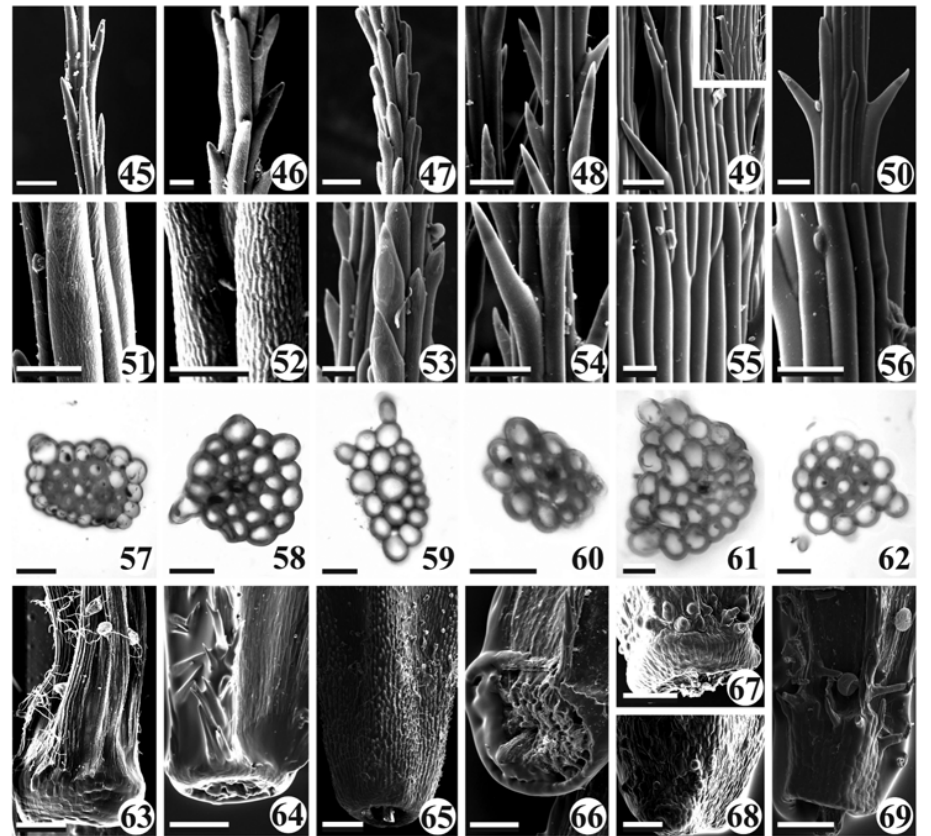
Fig. 4 – Micromorphology (first and second rows) and transversal sections of the pappus (third row), and micromorphology of the carpopodium (fourth row). Figs. 45, 51, 57, 63 – Campuloclinium macrocephalum . Figs. 46, 52, 58, 64 – Chromolaena stachyophylla . Figs. 47, 53, 59, 65 – Mikania micrantha . Figs. 48, 54, 60, 66 – Praxelis pauciflora . Figs. 49, 55, 61, 67, 68 – Symphyopappus reticulatus . Figs. 50, 56, 62, 69 – Vittetia orbiculata . Bars – 50 μ m (45, 47, 49); 20 μ m (46, 48, 50-62); 150 μ m